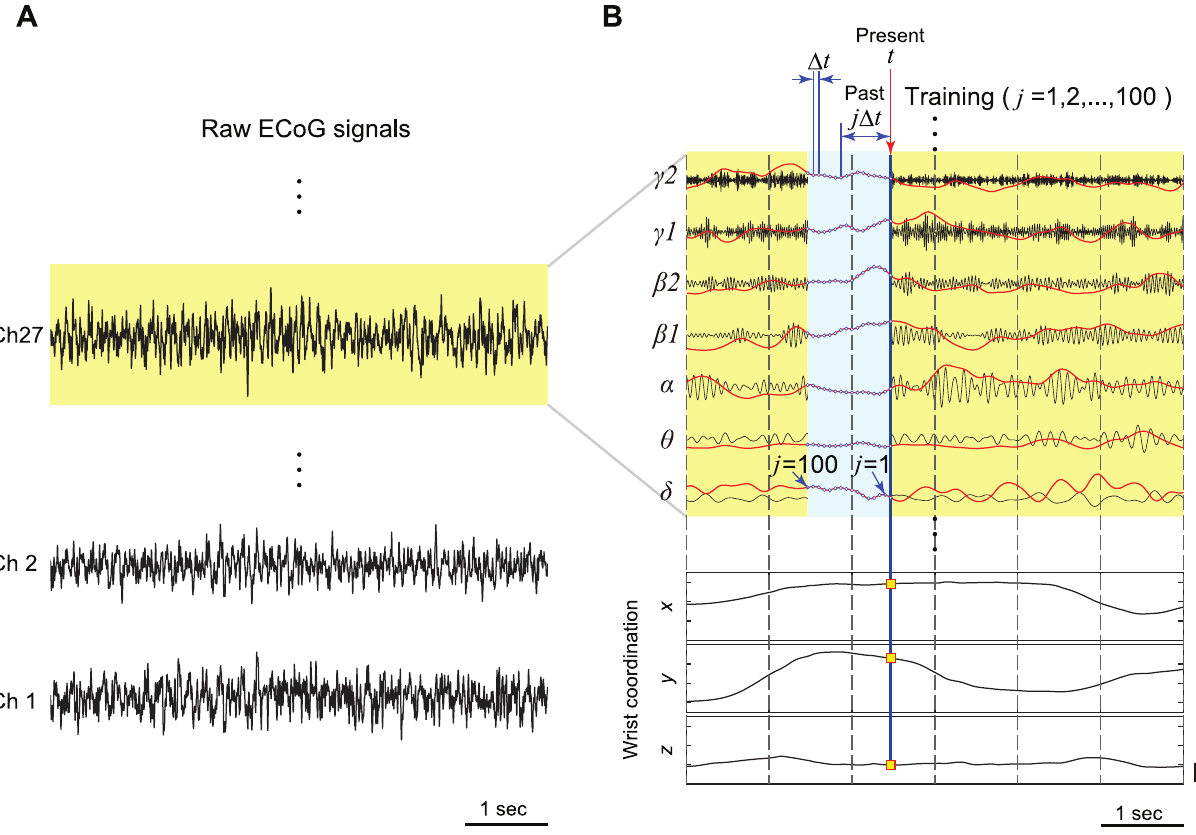
Figure3.ECoGsignalprocessinganddecodingmethod. (A)RawECoGsignalsfromchannels1,2,and27areshownastypicalexamples.(B)TheECoGsignal of channel 27 was divided into seven frequency components ( d , h , …, c 2) with bandpass filters (black lines). These seven filtered signals were digitally rectified, smoothed with a low-pass filter, and down-sampled to 100 Hz. The band-passed ECoG signals were then z -score normalized (red lines). The linear relationship betweenthepast1 sofnormalizedECoG(light-bluearea; t , t - j D t , j =1,2,…,100, D t =0.01 s,i.e.,100samplingpoints)andacoordinate x , y ,or z atthepresent t (tiny yellow boxes) was determined using sparse linear regression. Once weight coefficients were obtained through training, construction of the decoder was complete. doi:10.1371/journal.pone.0072085.g003 PLOS ONE |